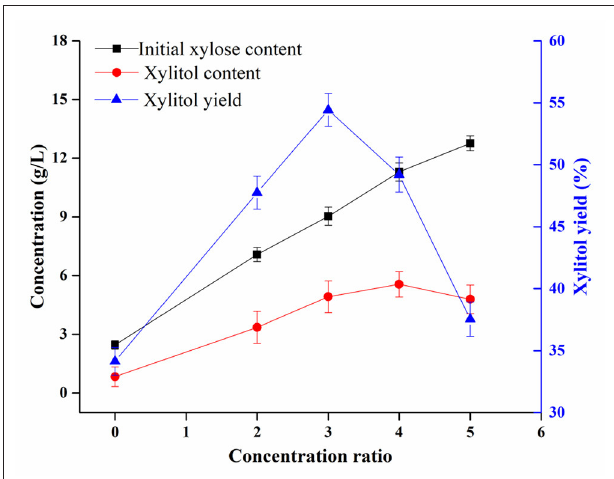
FIGURE 4 | Influence of the concentration ratio of the enzymatic hydrolysate of sugarcane bagasse on xylitol obtained by fermentation with Candida tropicalis .